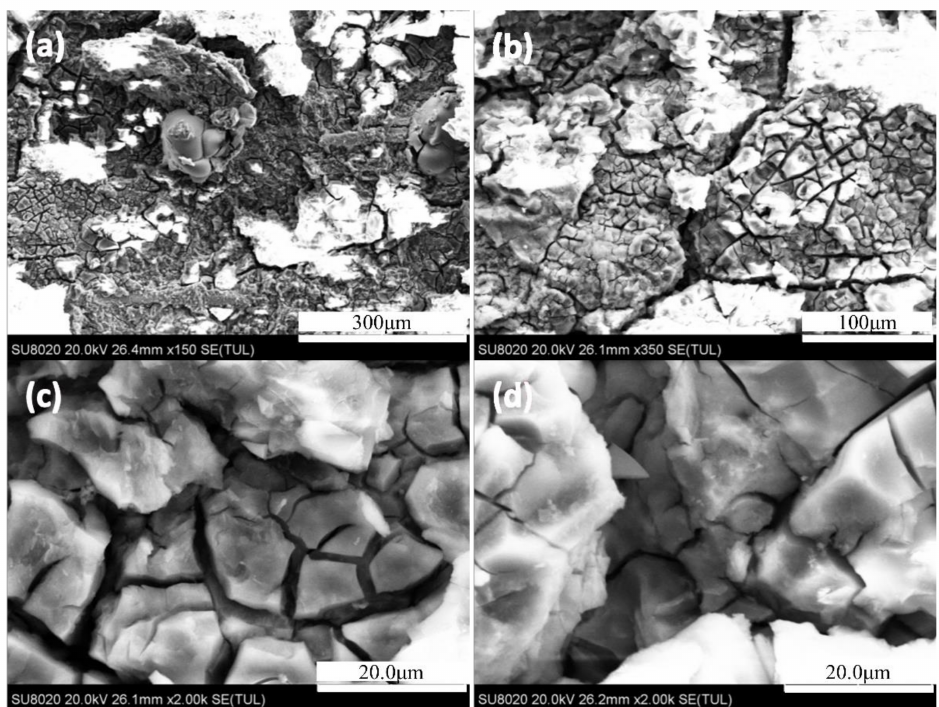
Figure 4. The internal morphology of the 7N01 extrusion aluminum alloy after single-peak aging at infiltrating 24 h: ( a , b ) SEM images under 150 magnification; ( c ) cracks in ( b ) under 2k magnification; ( d ) the gully in ( b ) under 2k magnification.